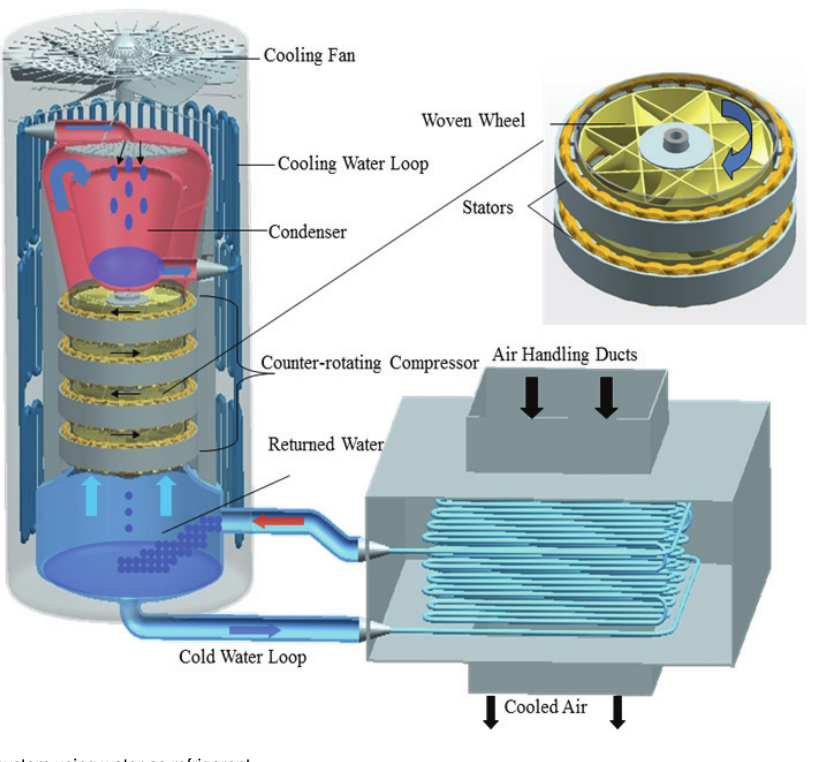
Fig. 1.Chiller system using water as refrigerant Figure 1. Chiller system using water as refrigerant.